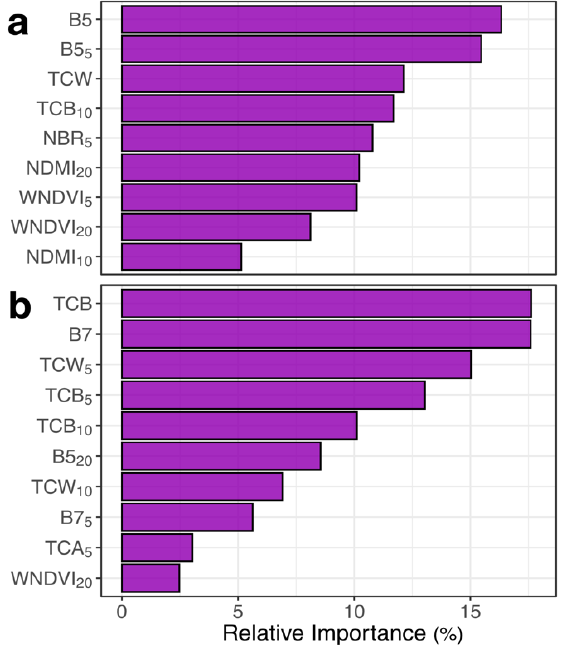
Figure 3. Variable importance plots for final Random Forest models of ( a ) presence and ( b ) severity of bark beetle-induced tree mortality in the Southern Rocky Mountains, USA. Individual predictors, representing the magnitude of spectral decline from specific Landsat bands or spectral indices 1996–2019, are ordered based on their contribution to model performance. Definitions of each band or spectral index are provided in Table 1. Subscripts refer to the scale of spatial segmentation (i.e., 5-, 10-, and 20-pixel seed spacing in Simple Non-Iterative Clustering) of annual maps prior to temporal segmentation, where higher values refer to a coarser-scale segmentation with larger image objects. Variables without subscripts were not spatially segmented, and thus represent the total disturbance in a 30-m voxel without accounting for neighborhood